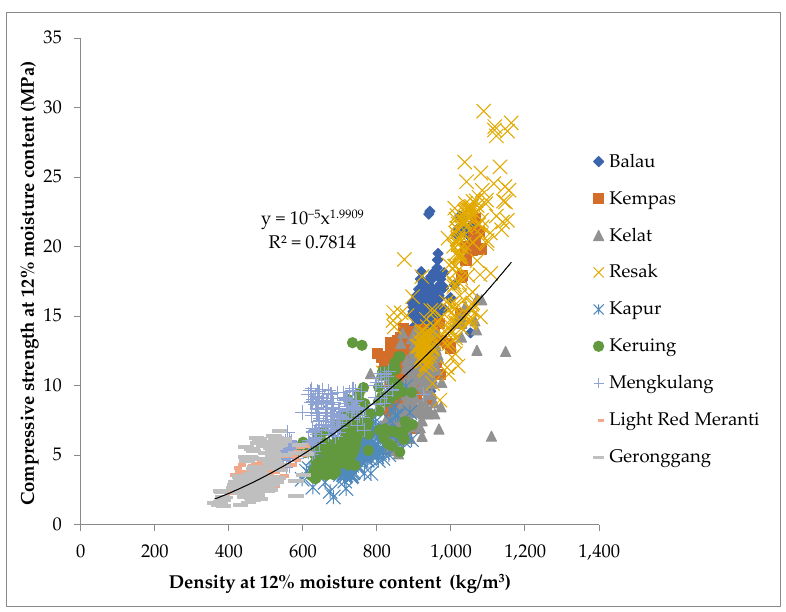
Figure 7. Relationship between compressive strength perpendicular to the grain and density for selected Malaysian tropical hardwood timbers.